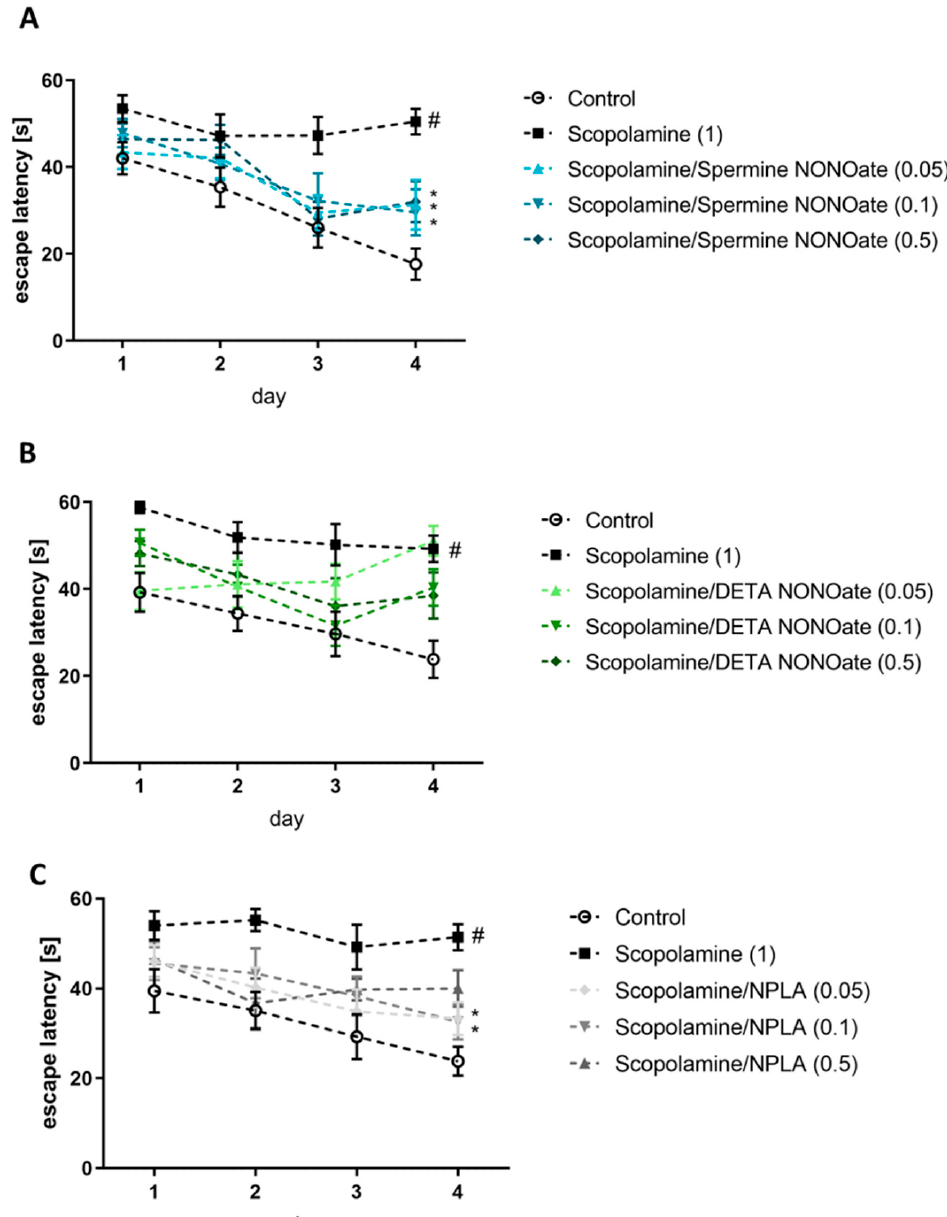
Figure 3. The effects of spermine NONOate ( A ), DETA NONOate ( B ), and NPLA ( C ) on scopolamine (1 mg/kg)–induced amnestic effect on the acquisition of spatial memory in the MWM of CD1 mice. The values are expressed as the means ± SEM. # p < 0.001 indicates the difference scopolamine-treated mice vs. the respective vehicle (N = 8–10), and * p < 0.05 indicates the difference between the scopolamine group and the treatment groups.